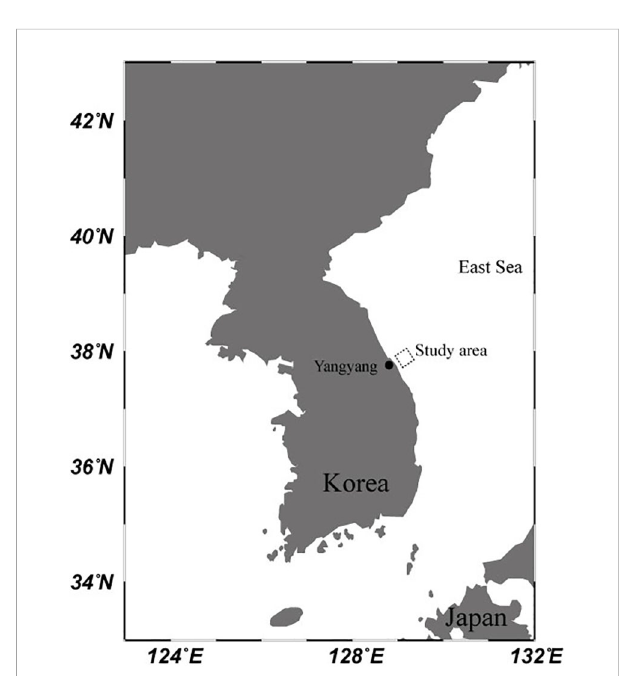
FIGURE 4 Location of sea trial sites for comparison of fi shing